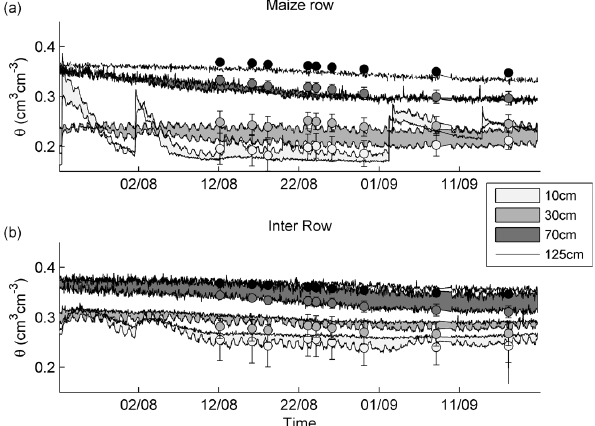
Fig. 8. Evolution of SWC at the four TDR measurement depths. The filled areas correspond to the SWC range based on two probe measurements in the row area (a) or in the inter-row area (b) . At 125-cm depth, only one probe was situated in the row area and one in the inter-row area. The circles are the ERT measurements at the same depth and at the corresponding time, and the bars are the mean ± one standard deviation for the corresponding ERT measurements. Light grey circles and filled areas are for 10cm, middle grey for 30cm, dark grey for 70cm, and black for 125cm.